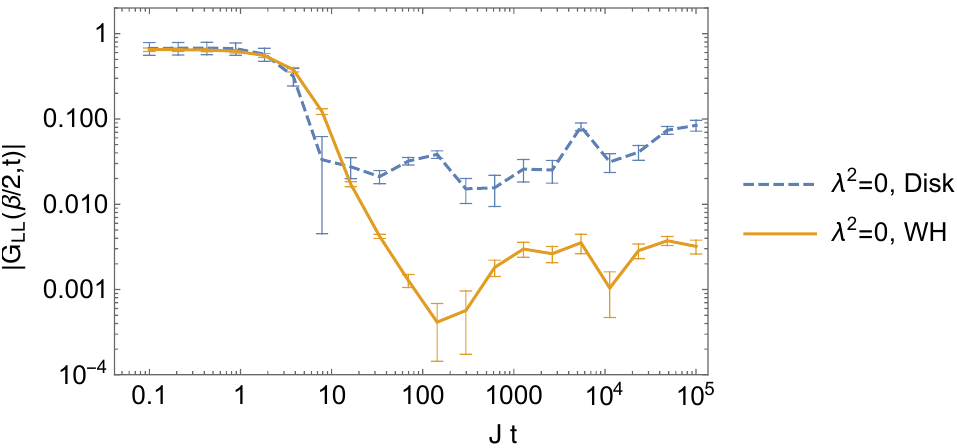
Figure 5 . The 2-pt correlator | G LL | as a function of Lorentzian time, where a single irrelevant q = 6 parameter is varied, as in figure 3. We take N = 20 , n trials = 2000 , β J = 1 , JT = 10 5 . The correlators are qualitatively similar to the case with many marginal parameters in figure